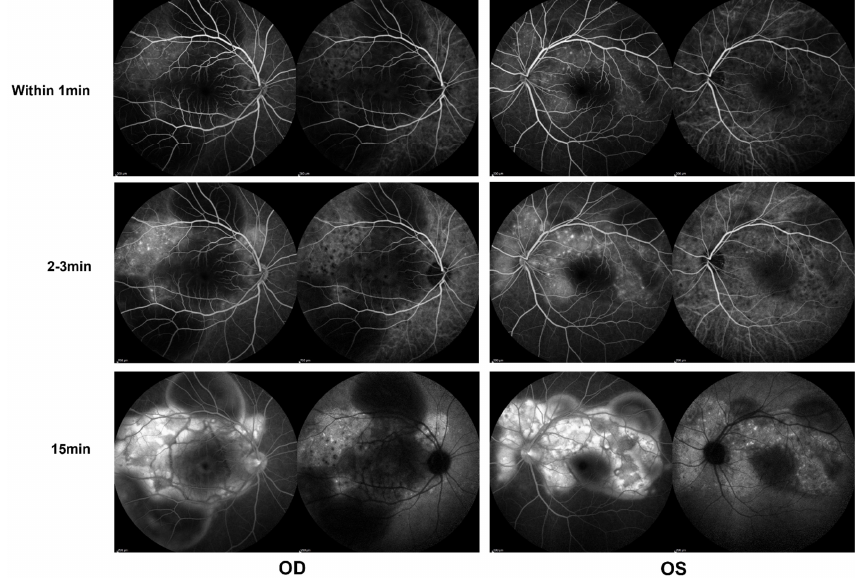
Figure 2. Indocyanine green angiography (ICGA) and fluorescein angiography (FA) (Heidelberg) during the first evaluation, showing early choroidal perfusion inhomogeneity, dot hyperfluorescence, and multiple areas of pinpoint hyperfluorescent foci with later-phase pooling OU.